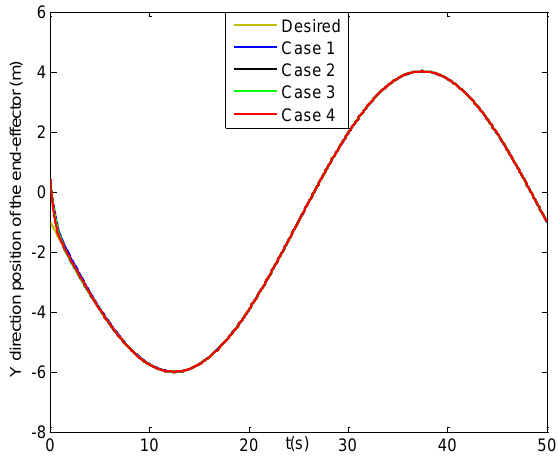
Figure 7. Y direction positions of the end − effector (four cases).